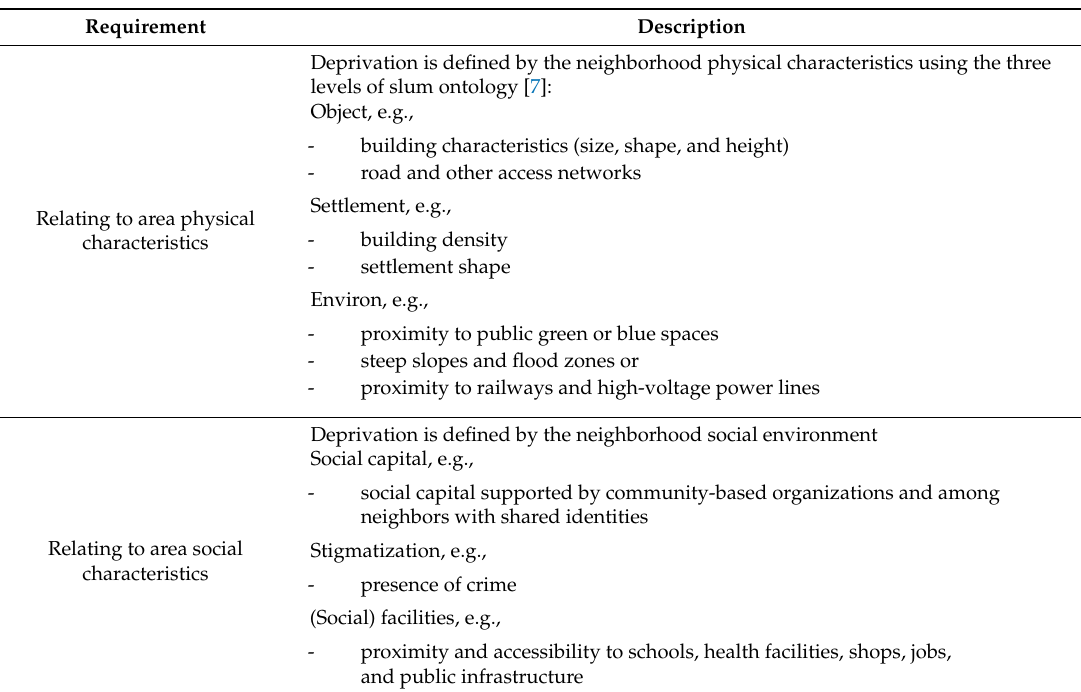
Table 1. Requirements for integrated deprived area maps (summarized partially from